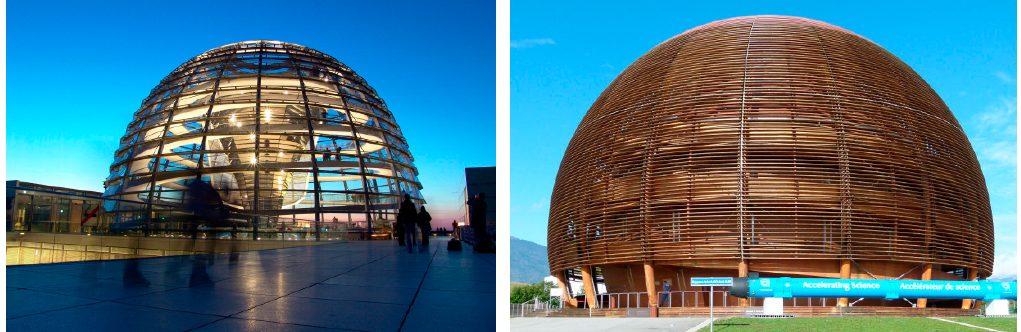
Figure 2. Example of modern geodesic dome building [17,18].